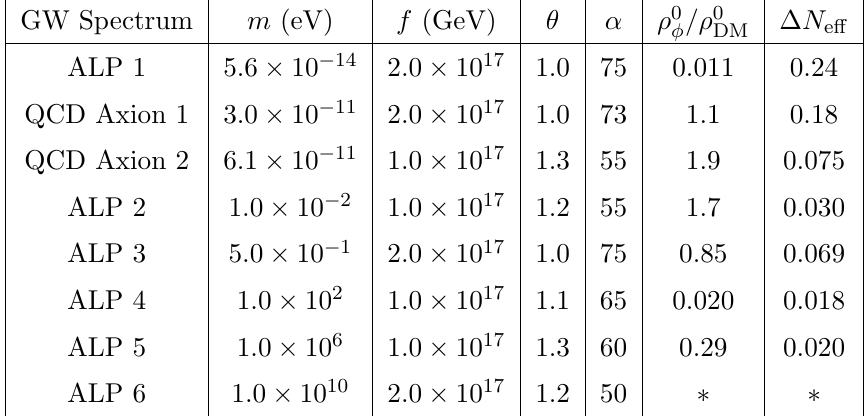
Table 1 . Parameter values for the gravitational wave spectra shown in (cid:12)gure 2. The present time ratio of the axion and DM energy densities is given by (cid:26) 0 where the axion is not cosmologically stable.